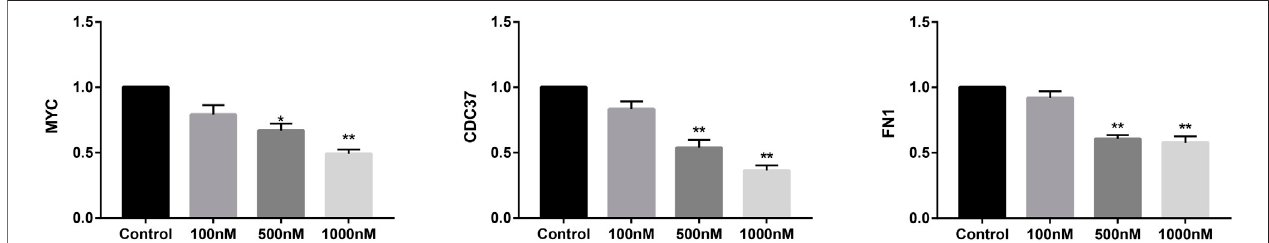
FIGURE 10 | Celastrol inhibited core target expression in ovarian cancer cells. Quantitative RT-PCR analysis of MYC, CDC37, and FN1 mRNA expression. Compared with the control group, * p < 0.05, ** p <